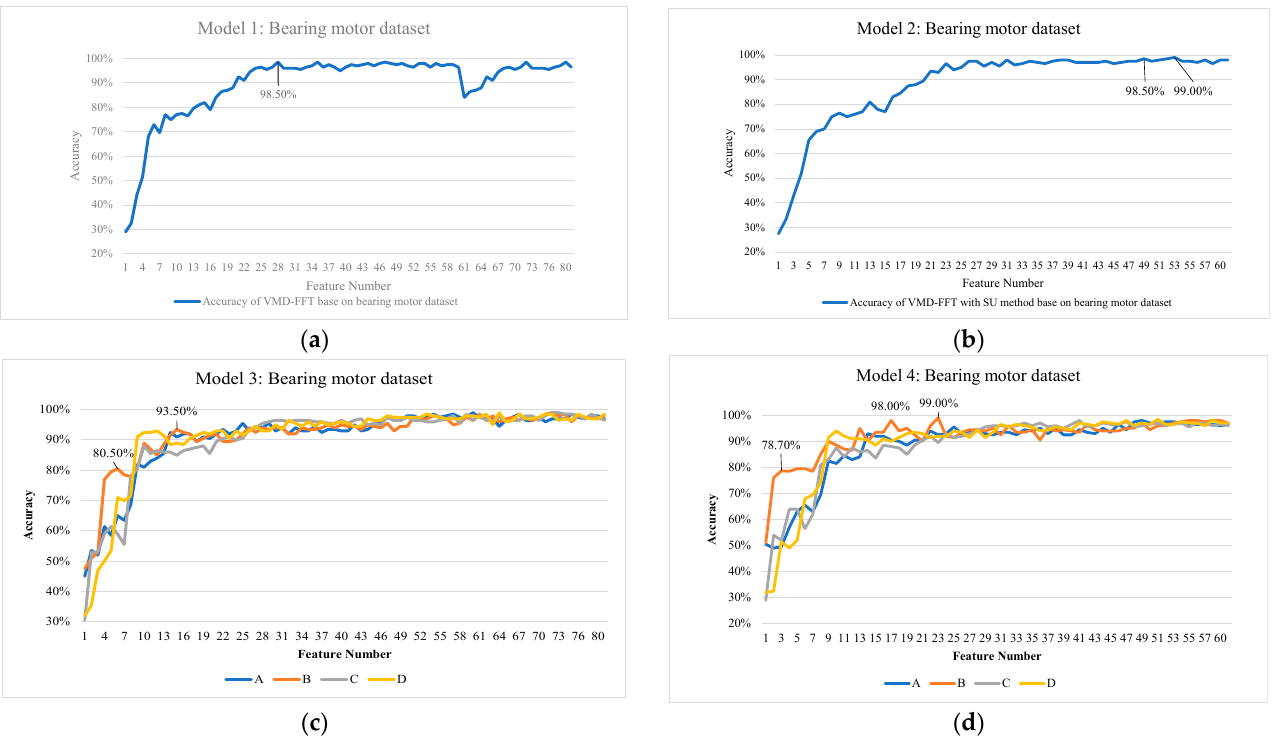
Figure 8. ( a ) Model 1: Bearing motor dataset of the VMD-FFT method in an SVM. ( b ) Model 2: Bearing motor dataset of the VMD-FFT method with redundant features removed by the SU method in an SVM. ( c ) Model 3: Bearing motor dataset of the TOPSIS method not removing features in an SVM. ( d ) Model 4: Bearing motor dataset of the TOPSIS method with redundant features removed by the SU method in an SVM. Table 5. Result in bearing motor current signal